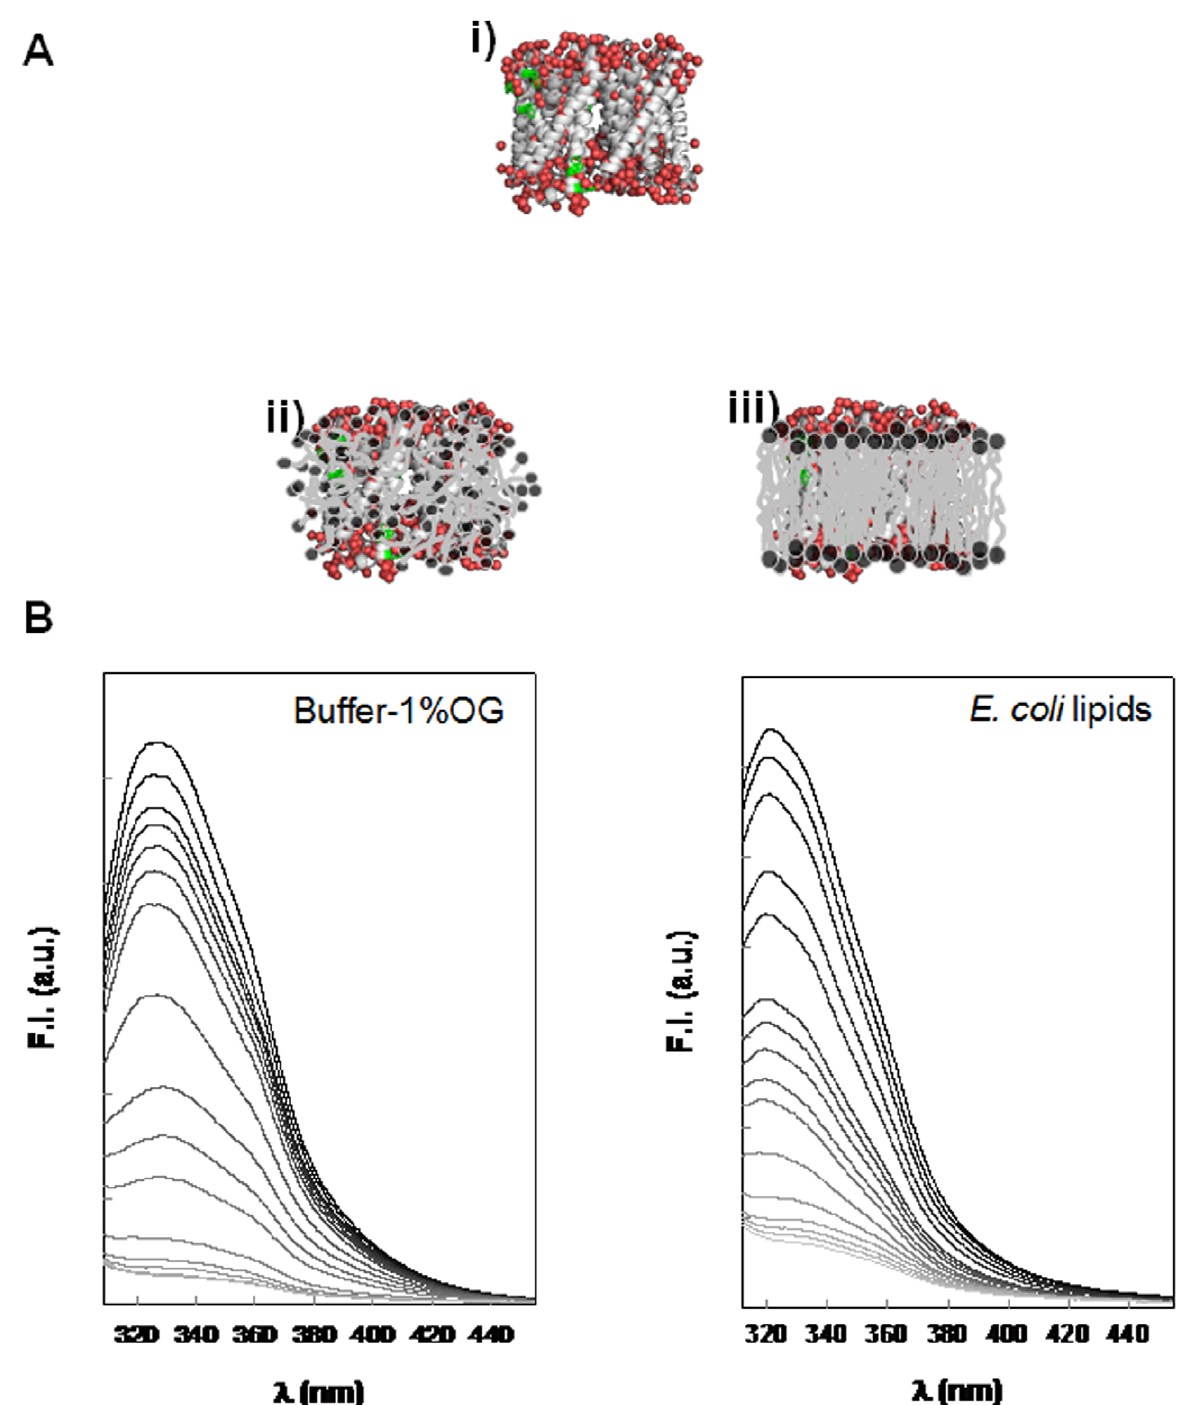
Figure 5. Fluorescence spectroscopy analysis of the protein ternary structure behavior. A) Cartoons illustrating the Trp residues (green) position in the protein ternary structure SoPIP2;1. The structure derives from the PDB file 1Z98 [22] using VMD software is shown in i [50], an illustration of the protein position in detergent micelles in ii and in lipid bilayers in iii. B) Thermal unfolding of SoPIP2;1 monitored by tryptophan fluorescence. To the left, the protein is reconstituted into OG micelles and to the right the protein is reconstituted into E. coli lipid membranes. Temperatures are represented by the grayscale colors from black, 20 u C to very light gray, 95 u C. doi:10.1371/journal.pone.0014674.g005 tors [36] showed using SDS-PAGE electrophoresis that E. coli maltoside (DDM). The same temperature was obtained for the GlpF aquaglyceroporin has an unfolding temperature of the tertiary structure monitored by Trp fluorescence [36]. When these tetramer around 60 u C in detergent solutions of dodecyl b -D- authors studied the secondary thermal stability by far-UV CD